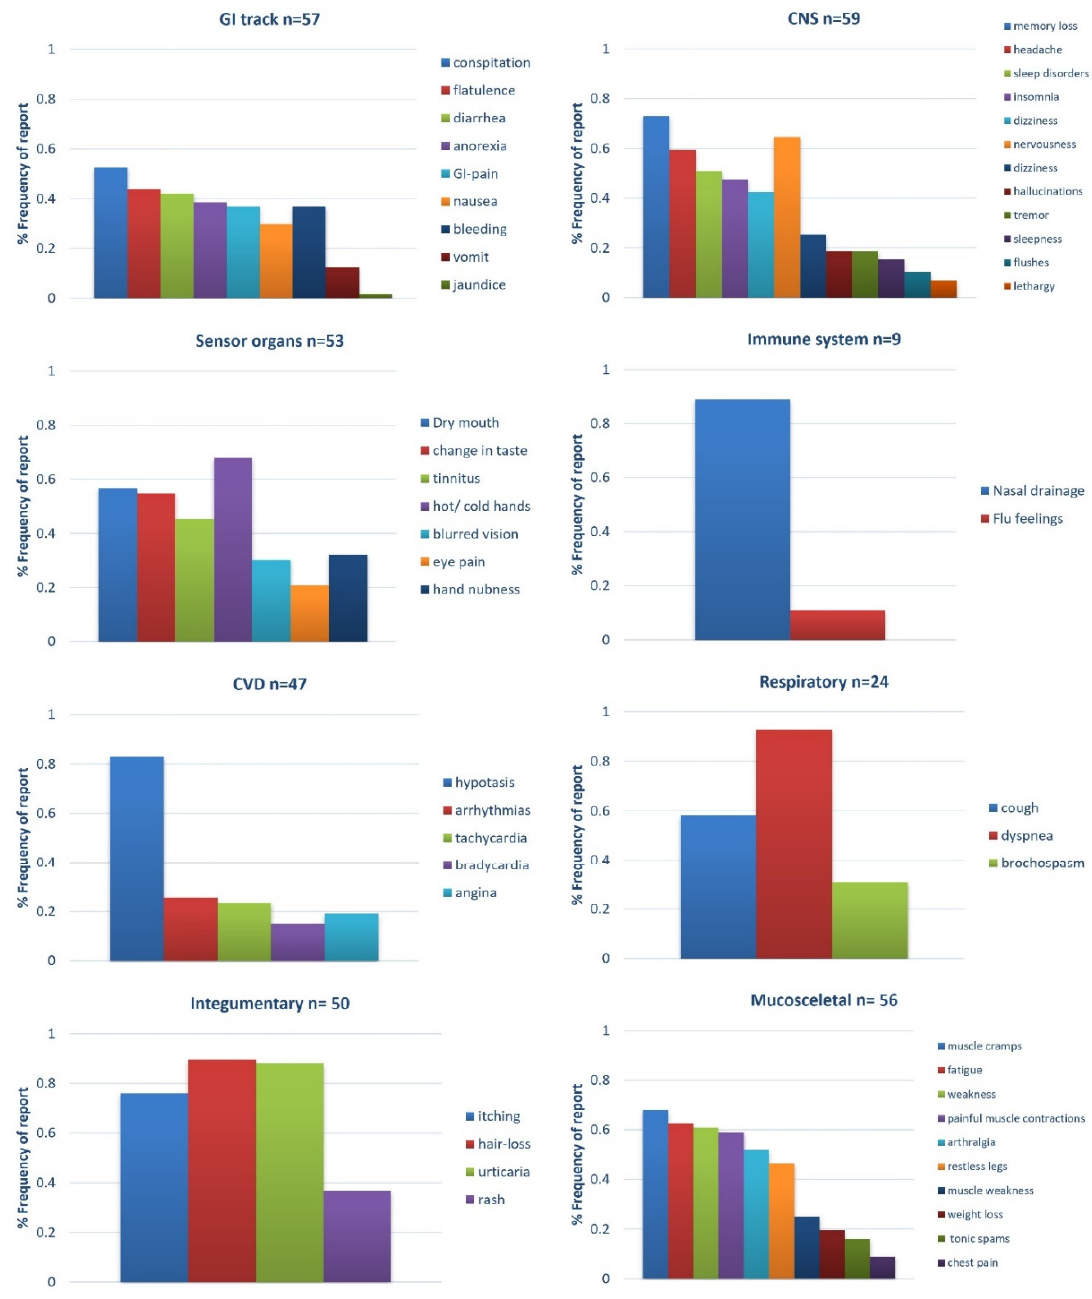
Figure 5. Distribution and frequency of reported ADE/ADRs in ESRD study group in relevance with related organ systems (GI: gastro-intestinal; CNS: Central Nervous related organ systems (GI: gastro-intestinal; CNS: Central Nervous System).